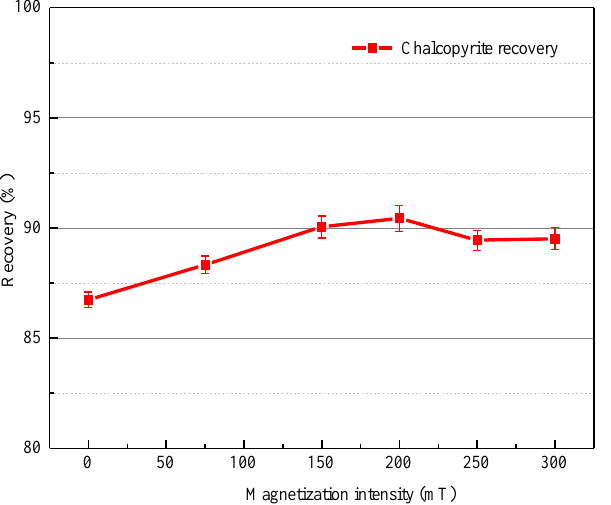
Figure 4. The relationship between the magnetization intensity and the recovery of chalcopyrite.